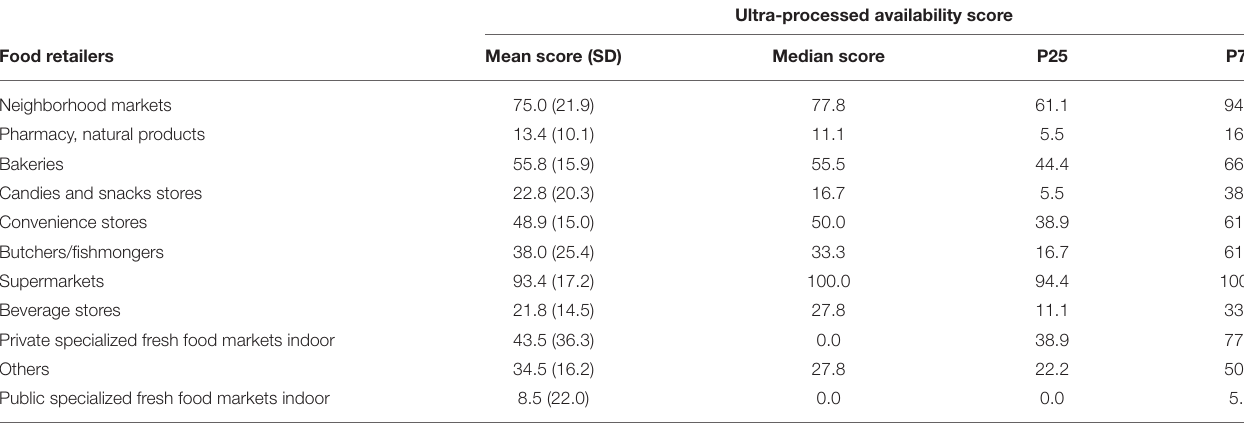
TABLE 2 | Mean (SD), median (p25, p75) of the ultra-processed availability score according to the food retailer type.